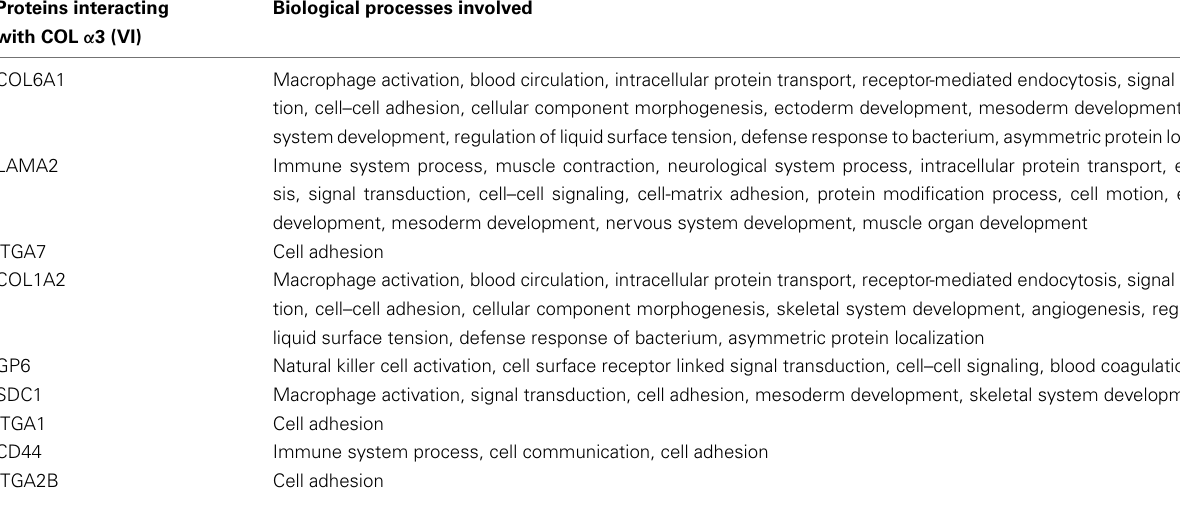
Table 5 | Biological function of proteins having interaction with α 3